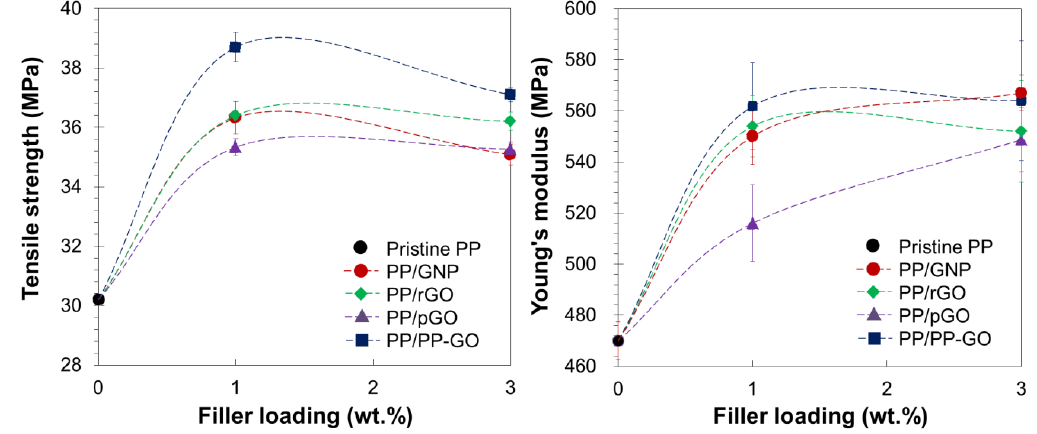
Figure 9. Tensile strength and Young’s modulus of PP nanocomposites at different filler loadings.